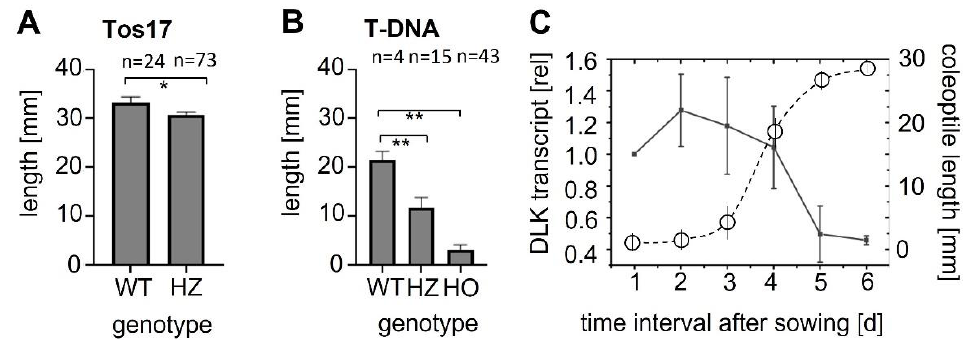
Figure 1. Relationship between DLK expression and coleoptile elongation. Mean length of fully expanded etiolated coleoptiles in the Tos − 17 insertion line ND4501_0_508_1A ( A ) and the T-DNA insertion line PFG_3A-07110.R ( B ). WT gives the values for the respective background (‘Nipponbare’ in ( A ), ‘Dongjin’ in ( B )), HZ for the genotyped heterozygotes, HO for the genotyped homozygotes, and n for the measured seedlings number for each genotype. Error bars represent SE, * significant at p < 5%, ** significant at p < 1% based on a homoskedastic t -test. ( C ) Time course for the steady-state levels of DLK transcripts in etiolated coleoptiles of ‘Nipponbare’ along with a growth curve of ‘Nipponbare’ coleoptiles under these conditions (circles, dotted curve). Each transcript measurement represents the mean from three individuals per experiment, repeated in three technical replicates, and each experiment was repeated in three independent biological series.